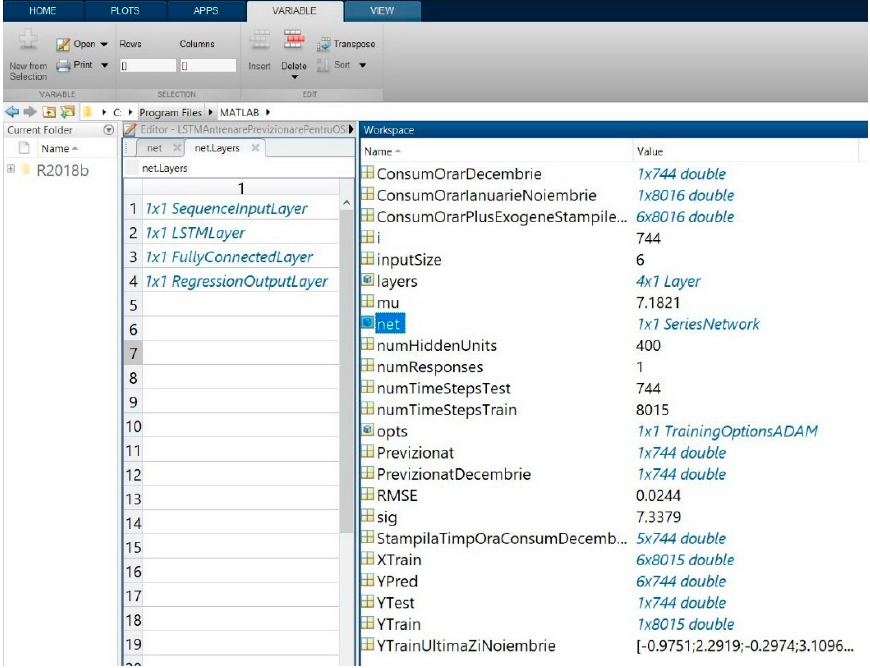
Figure 4. The architecture of the BEST_ long short-term memory LSTM) network.